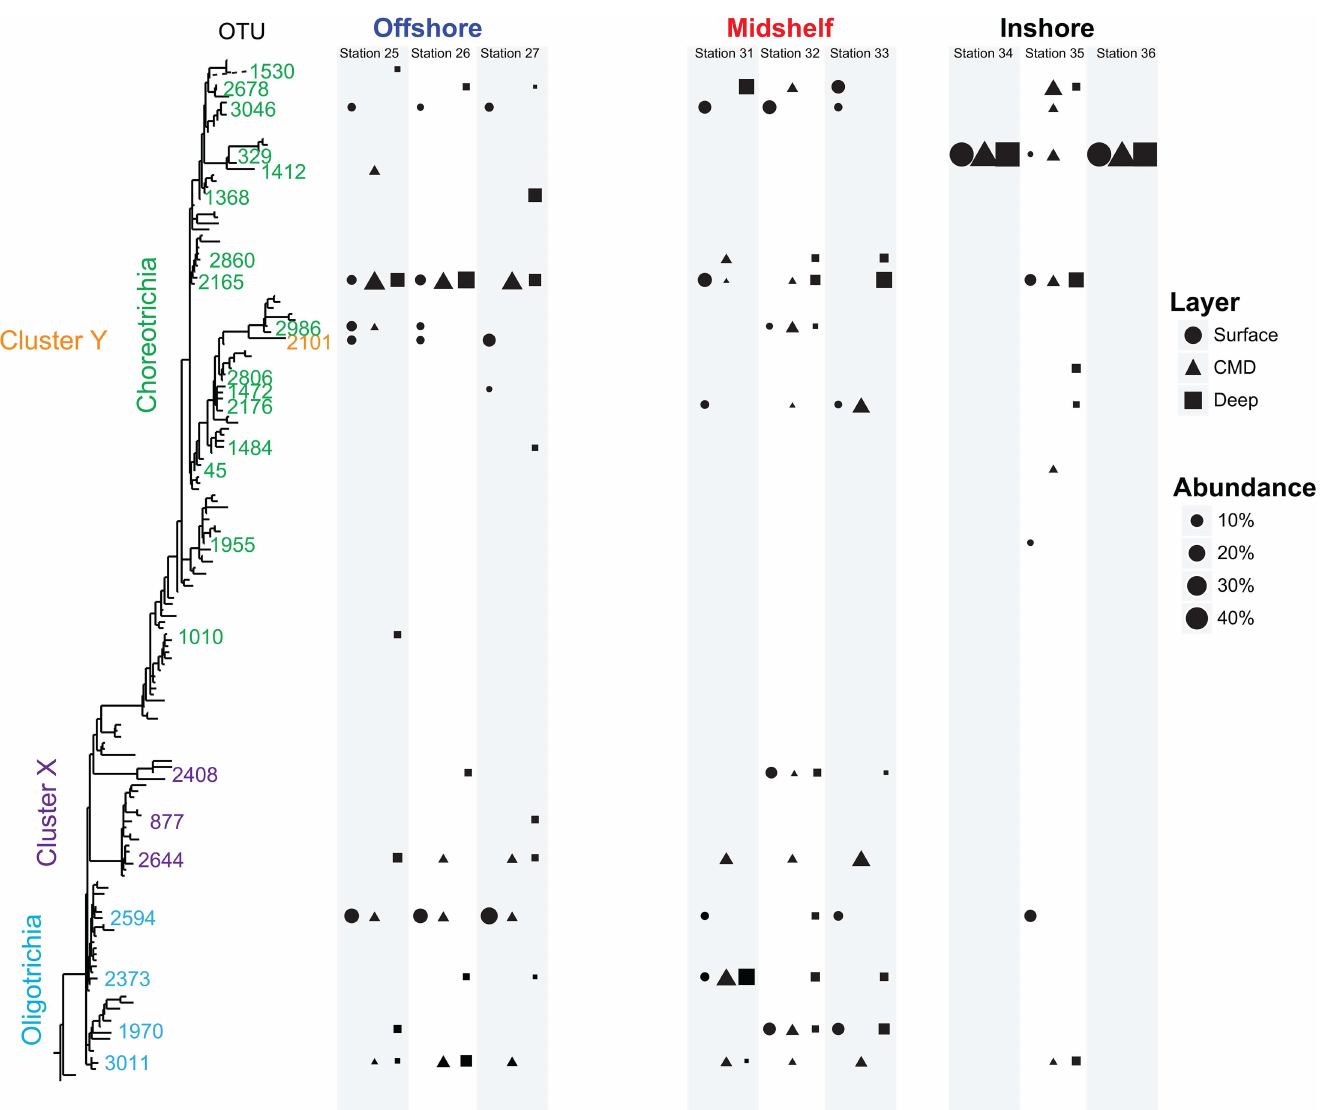
Fig 4. Heterogeneous patterns of OTUs (i.e. OTU specific to the inshore or to the offshore area, to the photic zone or to the deep) mapped onto phylogenetic tree. Only OTUs representing more than 5% of the communitieswere considered to observethe overall patterns. The bloom ciliate, OTU329 is evidentin Stations 34 and